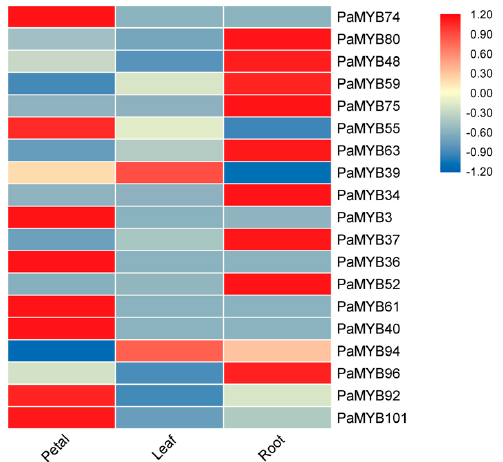
Figure 5. Tissue-specific gene expression of 19 R2R3-MYB genes of Petunia . The heat map shows the quantitative real-time polymerase chain reaction (qRT-PCR) analysis the expression level of PaMYB genes in in petal, leaf and roots. The gene expression level of tissue with highest expression level was considered as 1. Blocks with colors indicate decreased (blue) or increased (red) transcript accumulation relative to the respective